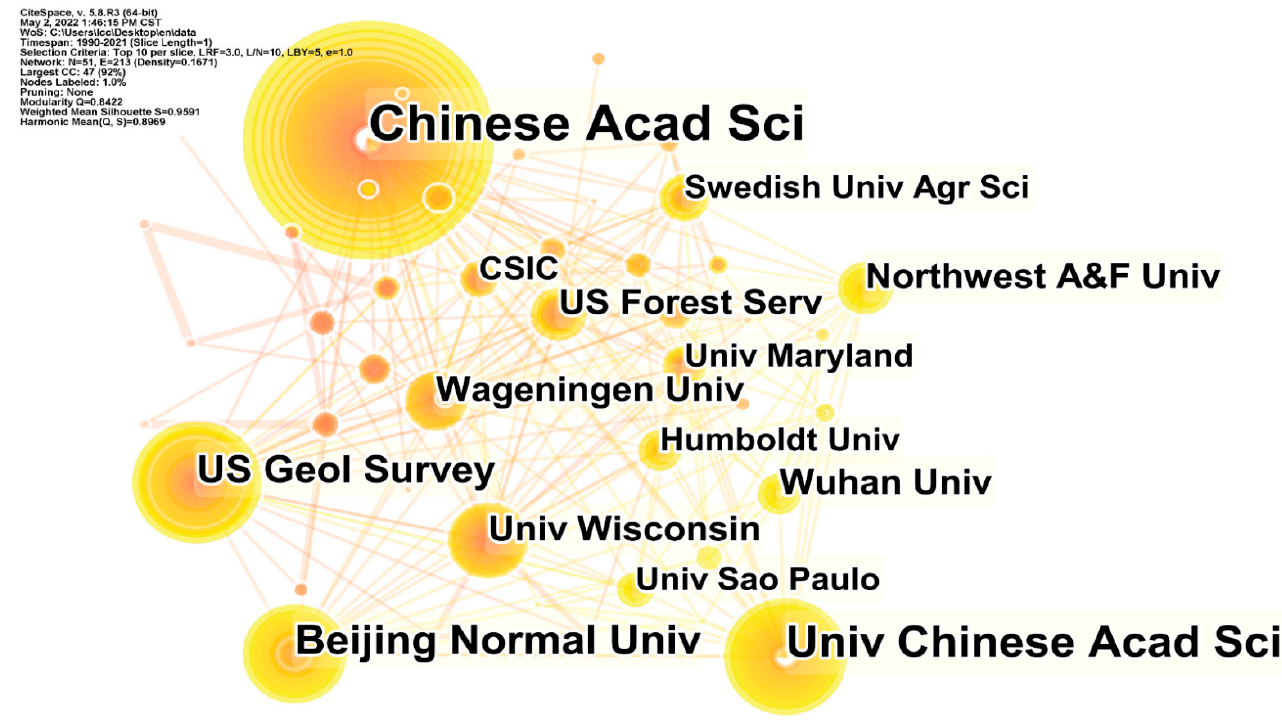
Figure 5. Map of the high–yield institution cooperation network.